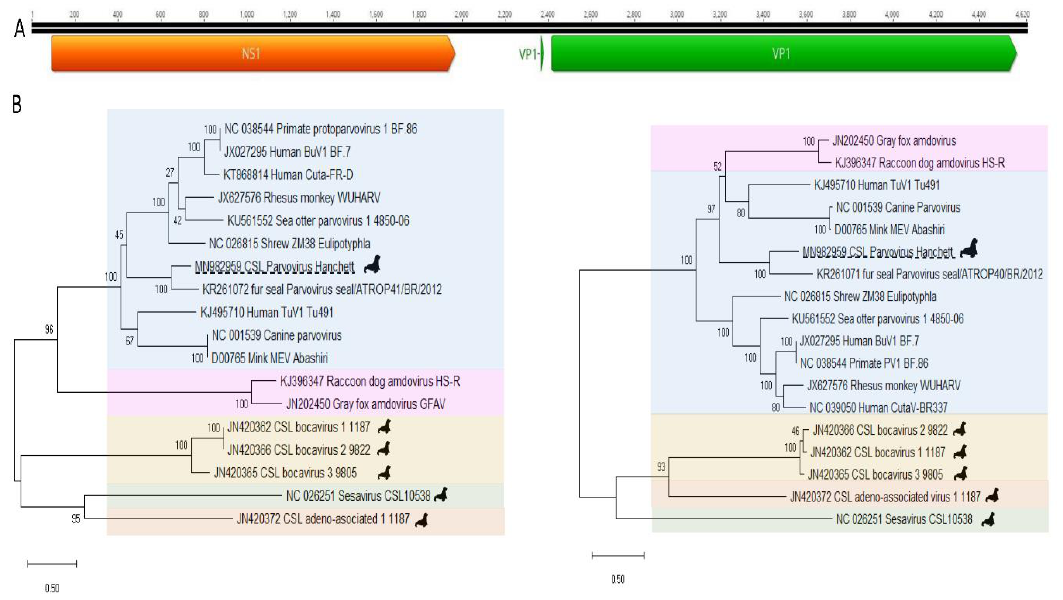
Figure 5. ( A ) California sea lion parvovirus Hanchett 2 ORF map and splicing motif as described